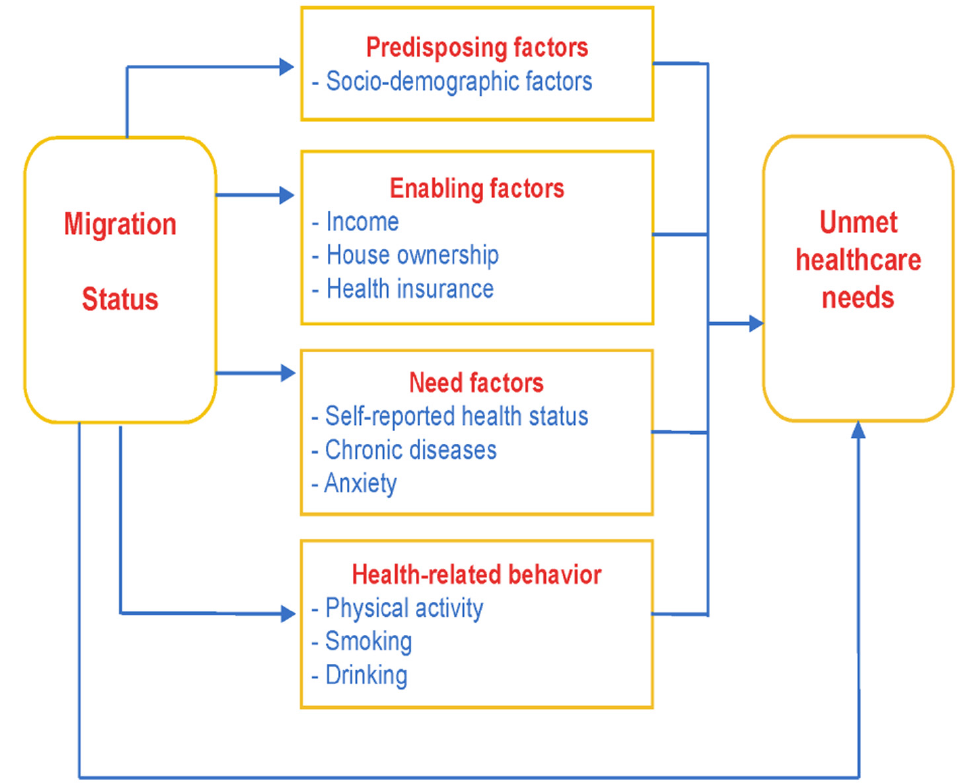
Figure 1. The simplified Anderson health behavioral model.